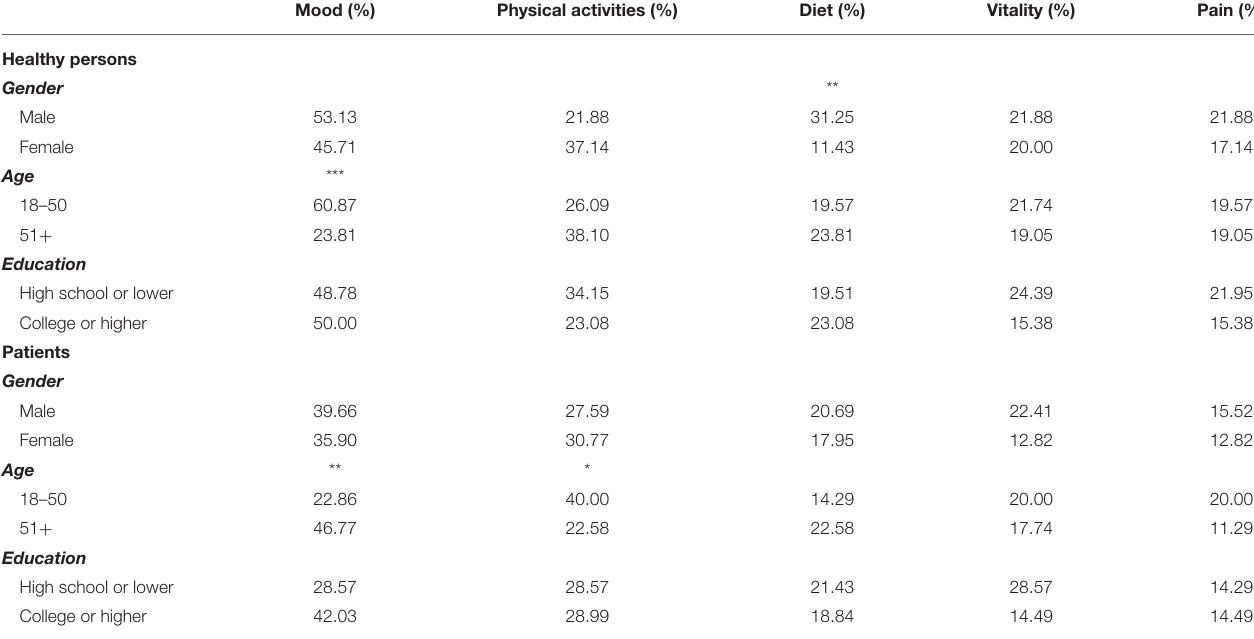
TABLE 3 | Difference in the importance of five most frequently mentioned dimensions among healthy persons and patients. Mood (%) Physical activities (%) Diet (%) Vitality (%) Pain